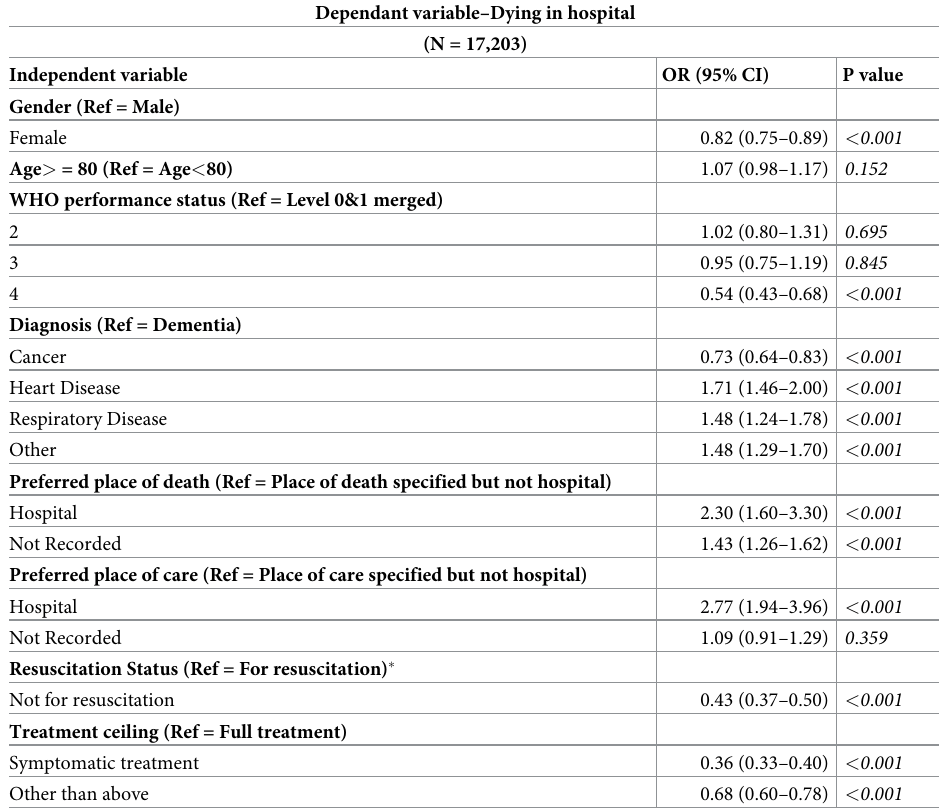
Table 2. Logistic regression analysis of the probability of dying in a